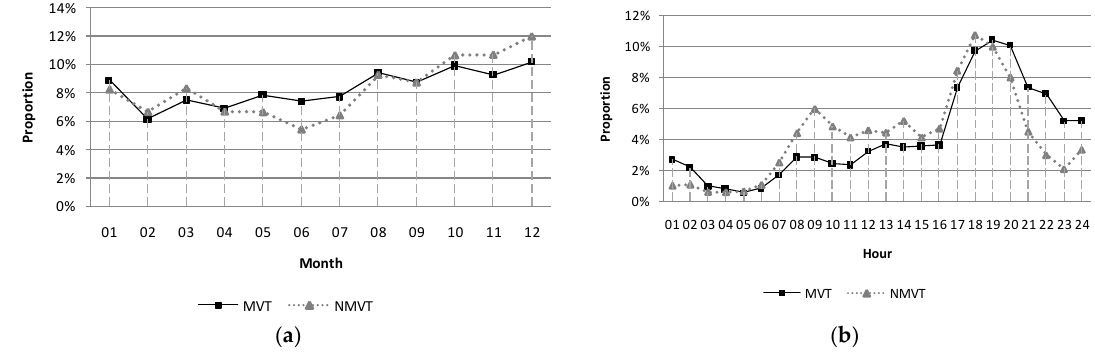
Figure 1. Distribution of vehicle theft cases by month ( a ) and by day ( b ).